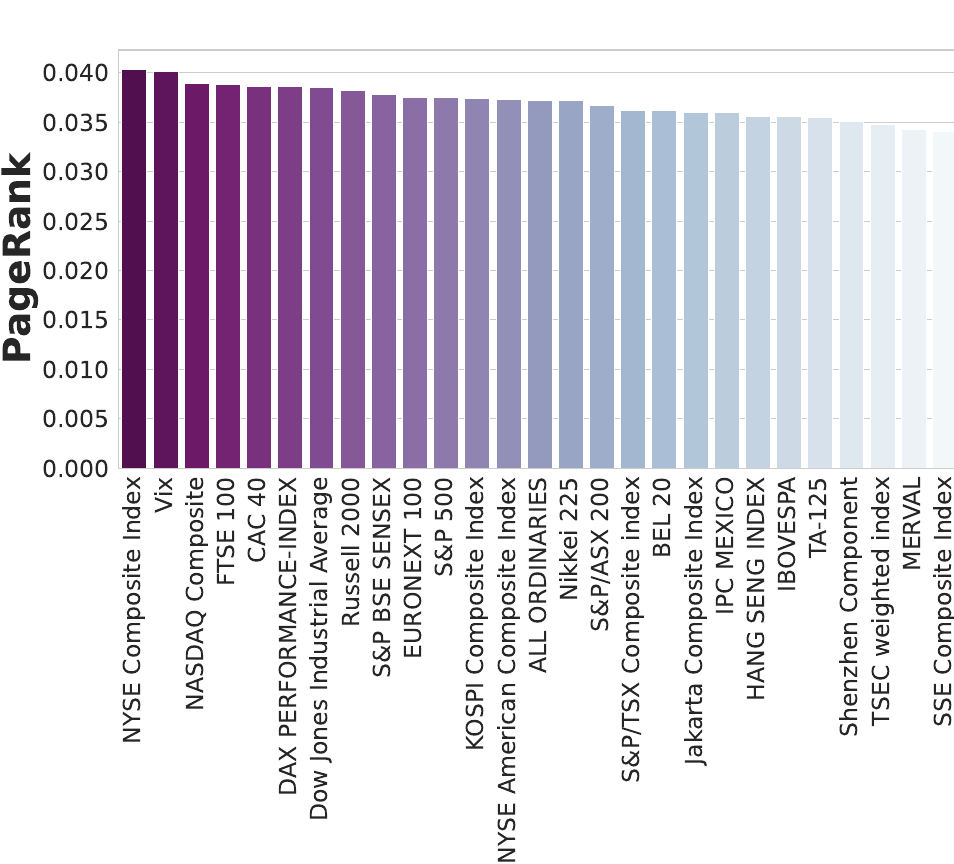
Figure 9. Centrality ranking by the PageRank suggesting the most influential international finance markets for the informational efficiency